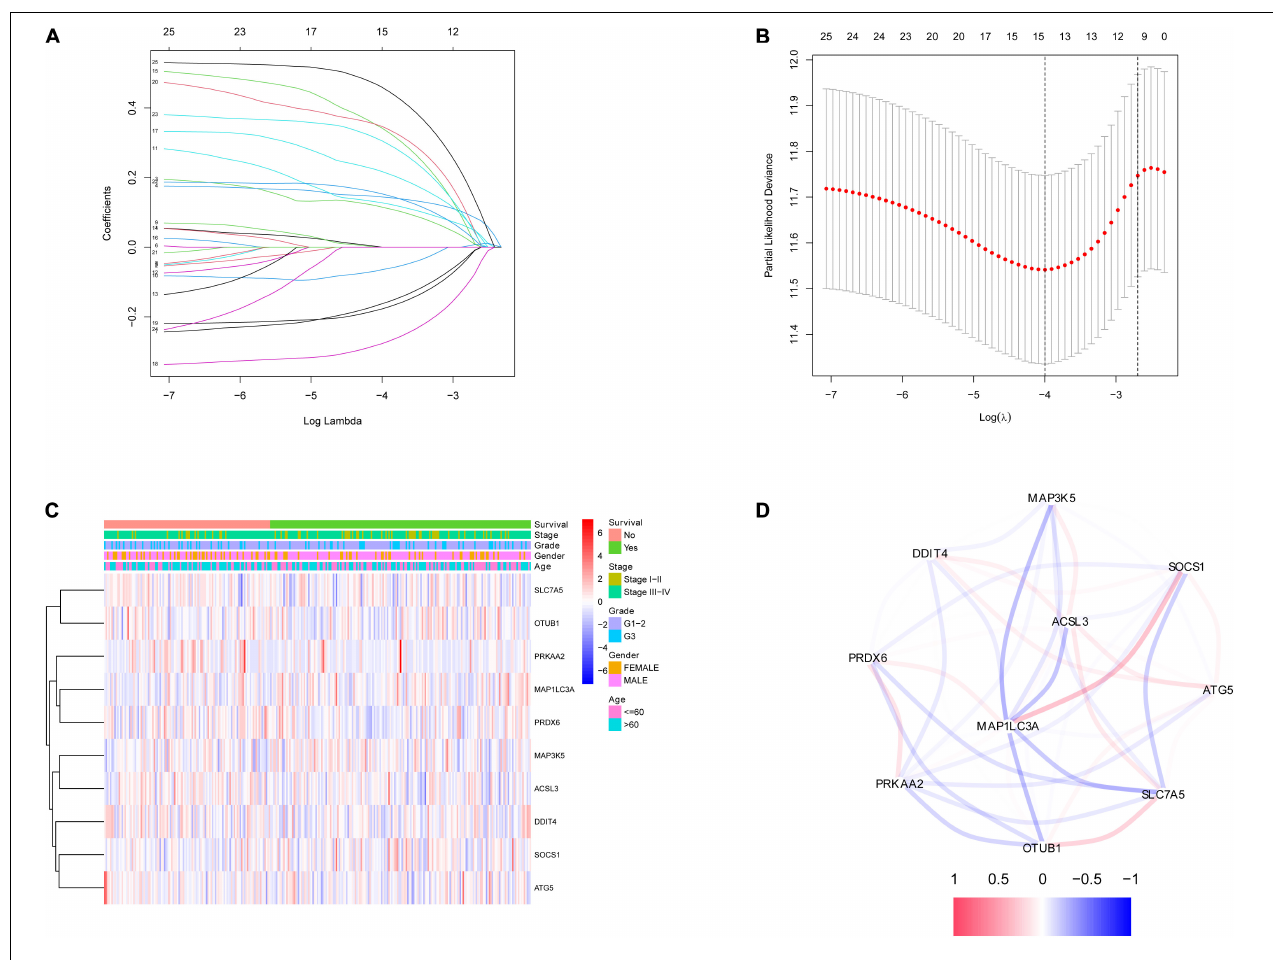
FIGURE 2 | Identification of ferroptosis-related signatures by LASSO regression algorithm in HNSCC. (A) LASSO coefficient profiles of the 25 ferroptosis-related genes. (B) Cross-validation for tuning parameter selection in the proportional hazards model. (C) The heatmap of the 10 ferroptosis-related genes. (D) The correlation of the 10 ferroptosis-related